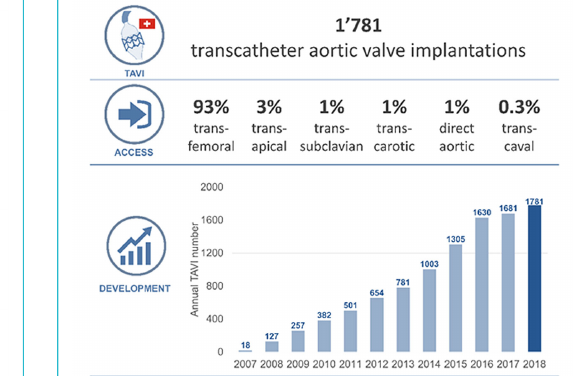
Figure 4: Transcatheter aortic valve implantations in Switzerland: summary 2018 and development